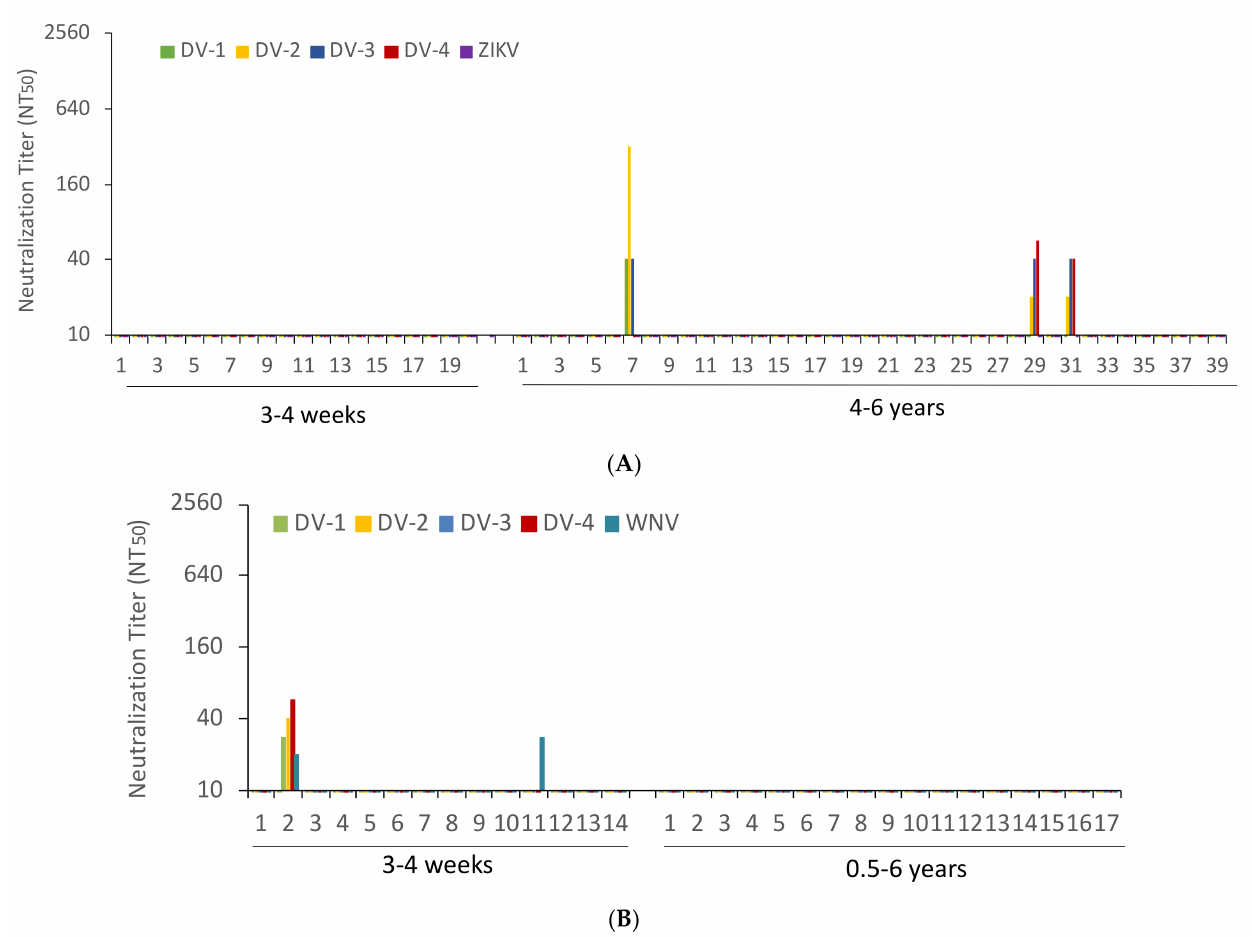
Figure 2. Dengue, zika and West Nile virus cross-neutralizing antibody titers. ( A ) Dengue (DV) and zika virus (ZIKV) NT 50 values obtained with the sera of patients tested 3–4 weeks (N = 20) and 4–6 years (N = 39) after YFV immunization. ( B ) Dengue (DV) and West Nile virus (WNV) NT 50 values of sera of patients tested 3–4 weeks (N = 14) and 0.5–6 years (N = 17) after JEV